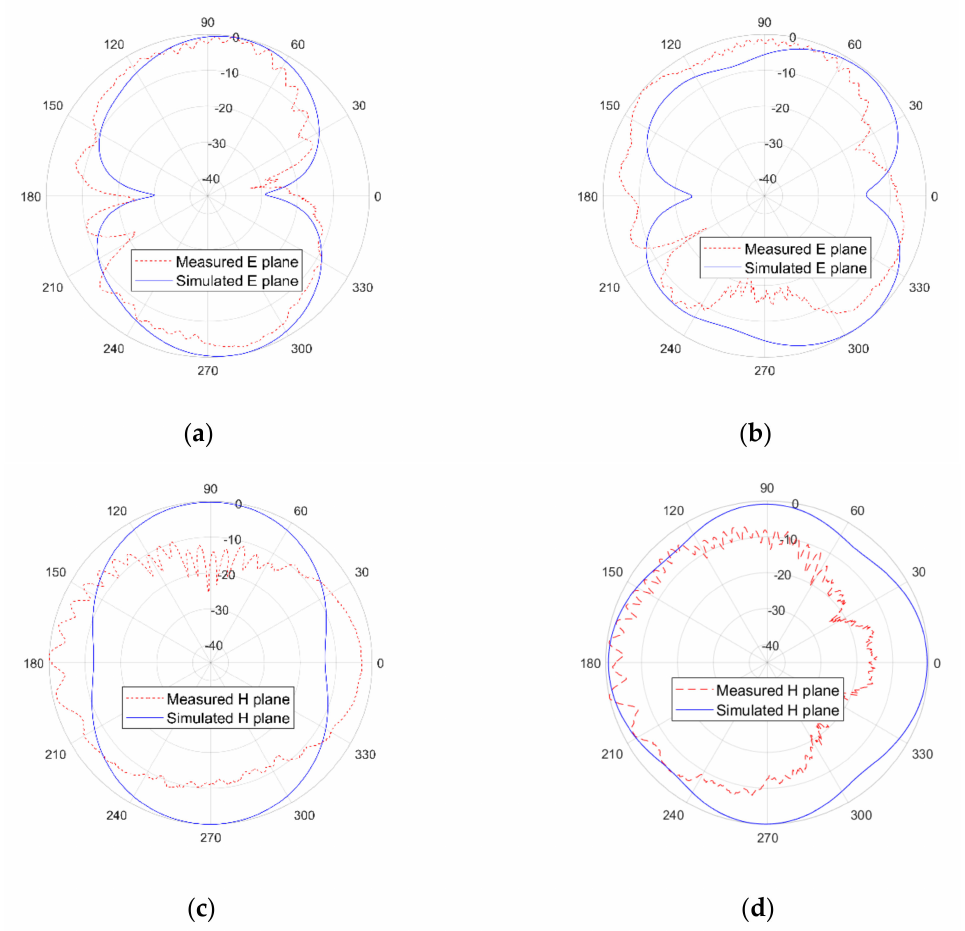
Figure 4. Simulated and measured radiation patterns for ( a ) the E plane of 5 GHz, ( b ) E plane of 7 GHz, ( c ) H plane of 5 GHz, and ( d ) H plane of 7